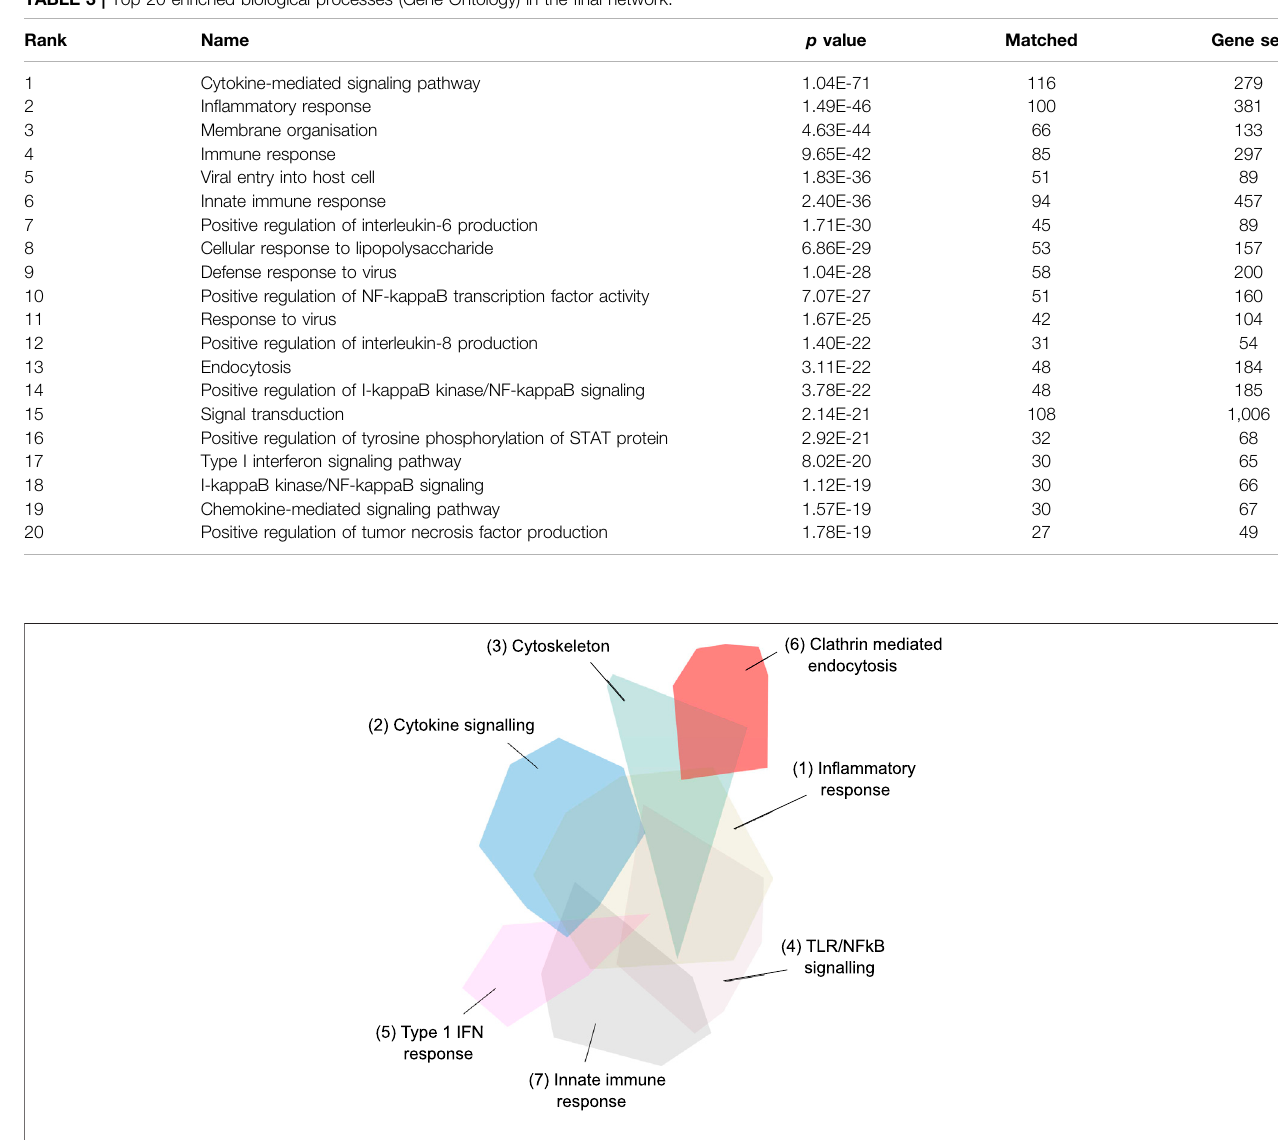
FIGURE 5 | Third iteration, fourth and fi nal network - 657 genes in 20 network modules identi fi ed via Louvain-based community detection using protein-protein interactions. The largest 7 modules are annotated.